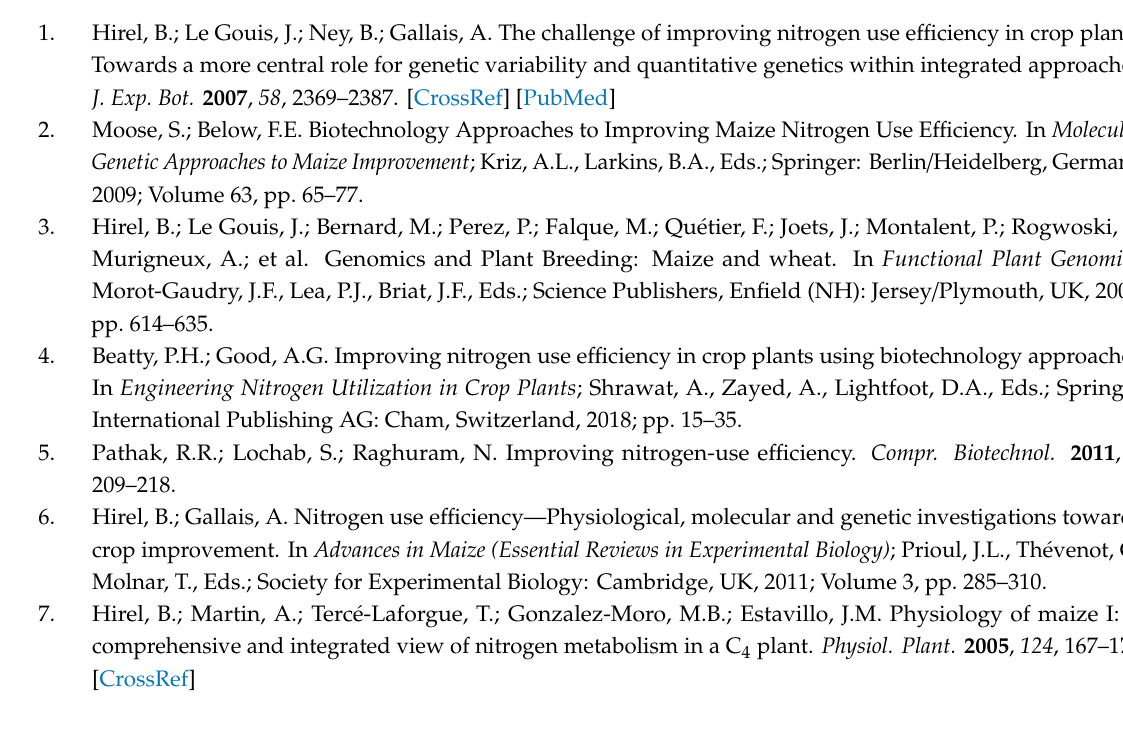
Table S1: Characteristics of the di ff erent constructs used for maize transformation, Table S2: List of primers used for RT-qPCR experiments, Figure S1: Transcript abundance for NADH-GOGAT, NAD-IDH, NADH-GDH1 and GS1.3 in the leaves of transgenic plants overexpressing NADH-GOGAT (construct T02291) or stacked with the three other genes (constructs T02289, T02308 and T02312), Figure S2: Hierarchical clustering analysis of metabolites and at the V stage and 15DAS in the WT plants and in the transgenic maize lines, Figure S3: Correlation matrix for the leaf metabolite content at the V stage., Supplemental data set 1: Leaf metabolite quantification following GC-MS analysis, Supplemental data set 2: Normalized quantification of leaf metabolites, Supplemental data set 3: Comparison of metabolite accumulation between the WT (A188) and the four di ff erent transgenic lines, Supplemental data set 4: Pearson correlations for leaf metabolites content, biomass and yield-related traits at the V stage, Supplemental data set 5: P values from the Pearson correlation matrix of V stage data. Supplemental data set 6: Groups of metabolites obtained following hierarchical clustering of the Pearson correlations between the amount of leaf metabolites at the V stage, shoot dry weight and yield-related